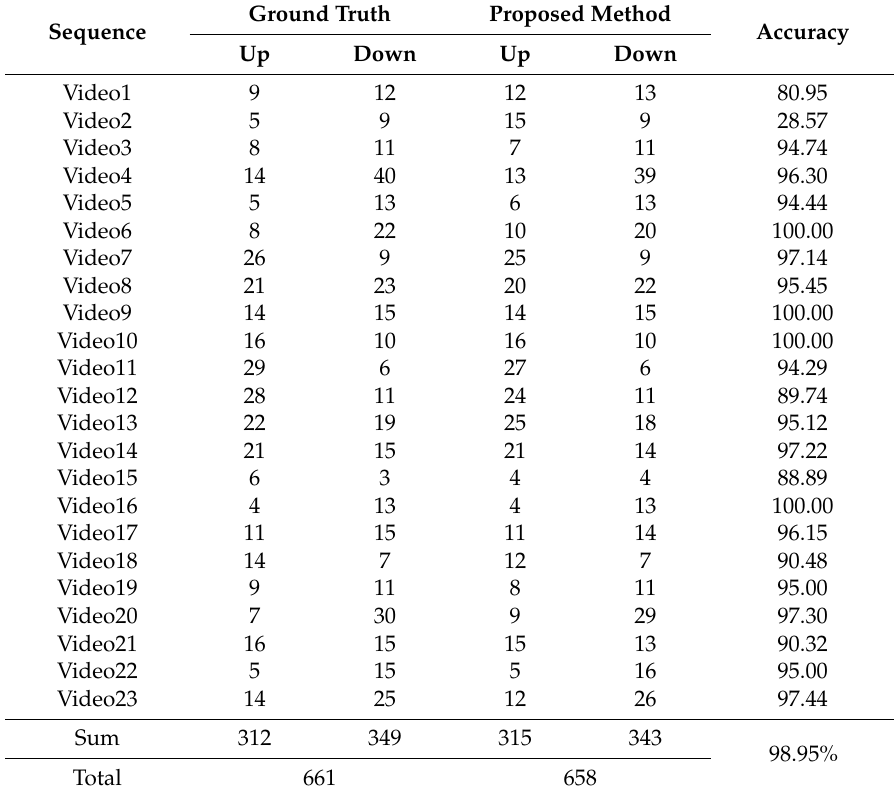
Table 2. People counting accuracy of the proposed